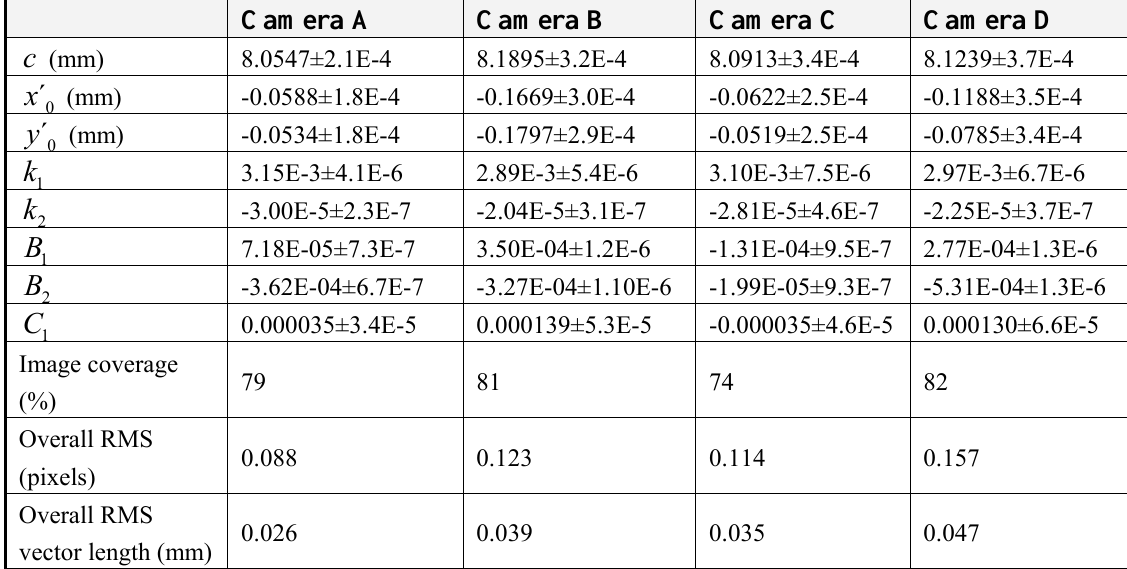
Table 3. Interior orientation parameters and quality variables (image coverage, global point-marking residuals and global point precisions) obtained as results from modelling of the cameras.